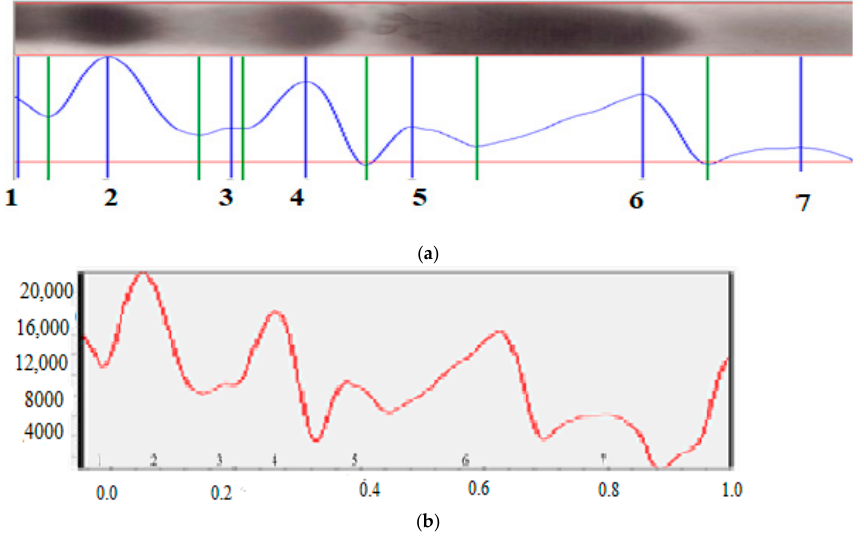
Figure 5 . С hromatograms: ( a ) с hromatographic plate view with eluent distribution, ( b ) Figure 5. Chromatograms: ( a ) chromatographic plate view with eluent distribution, ( b ) chromatogram chromatogram of lipid classes of C. Sorokiniana microalgae biomass of lipid classes of C. Sorokiniana microalgae biomass